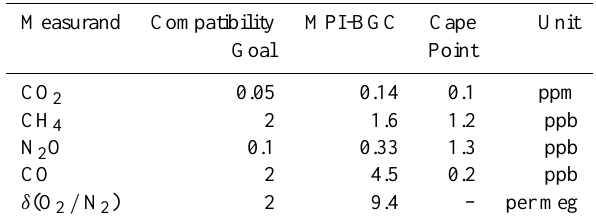
Table 2. Measurement compatibility with cape point observatory and MPI-BGC (flask vs. in situ), with reference to WMO/GAW goals (WMO/GAW,